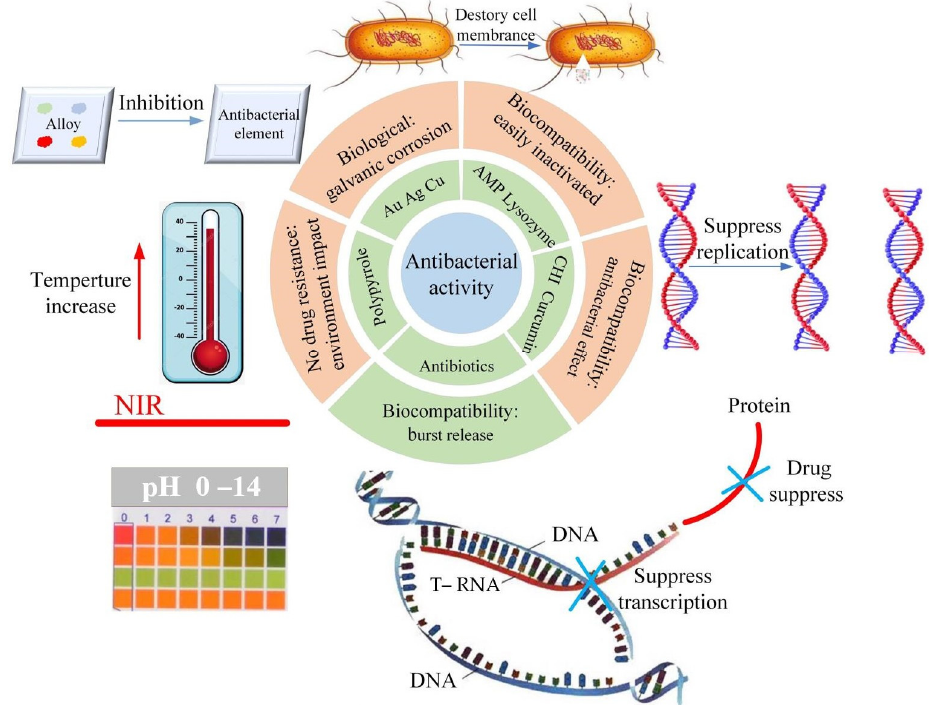
Figure 14. Features and mechanisms of commonly used antimicrobial substances.